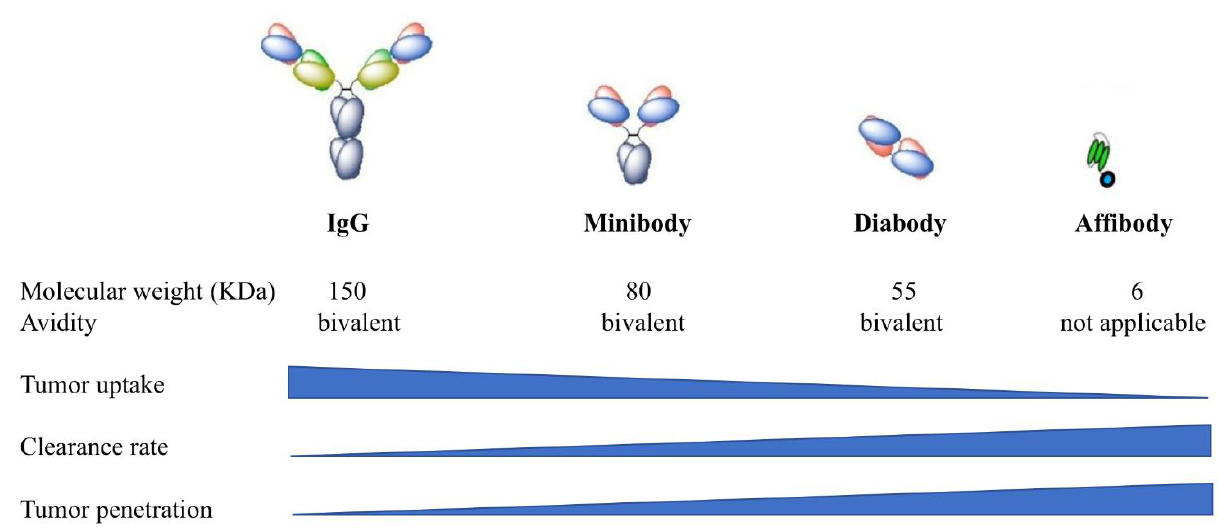
Figure 4. Comparison of full-length antibodies (IgG), minibodies, diabodies, and affibodies. Reprinted with permission from ref. [85]. Copyright 2018 Chemistry Europe.